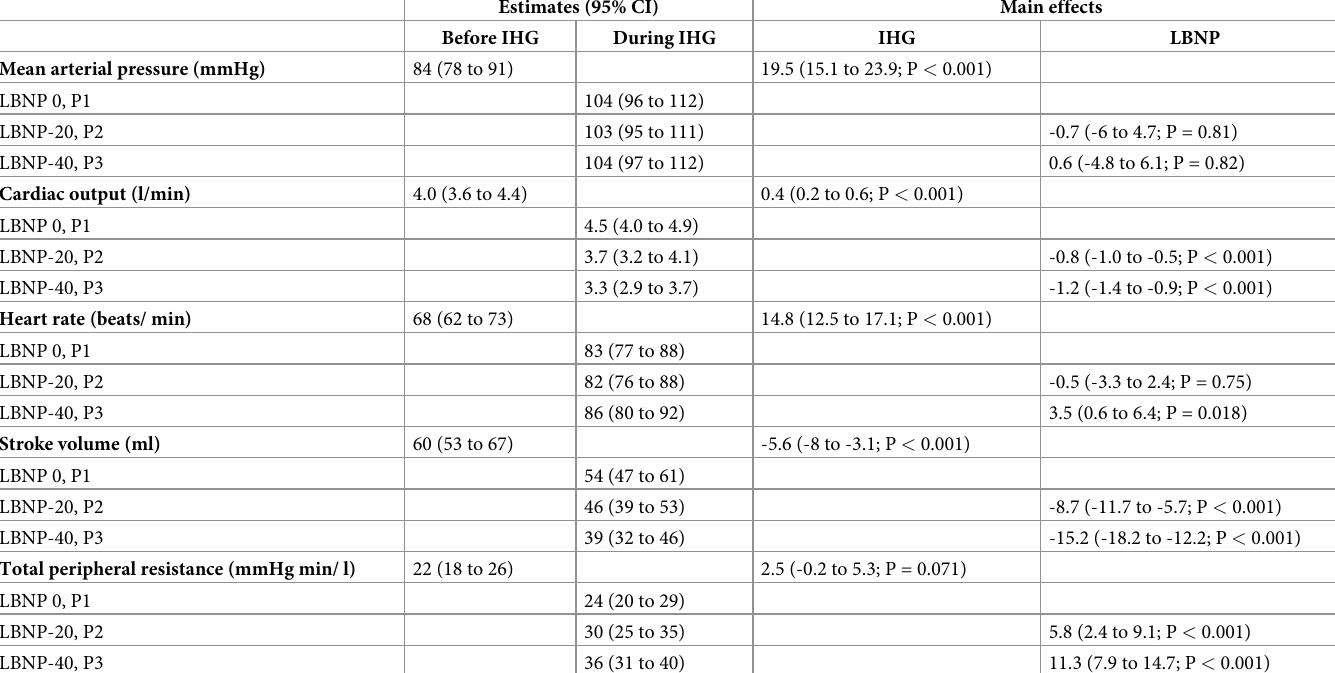
Table 2. Hemodynamic response to IHG and transient